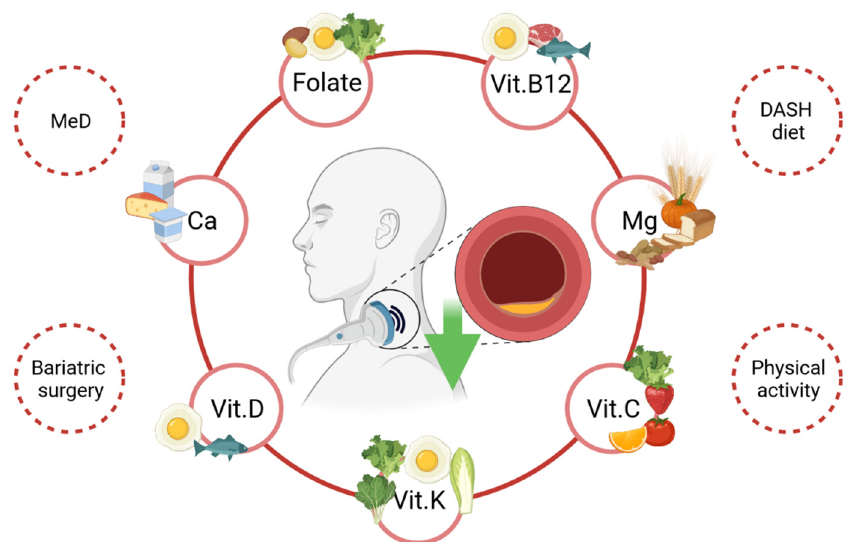
Figure 3. Behavioural and clinical factors that can reduce the cIMT values. MeD—Mediterranean diet; DASH—Dietary Approach to Stop Hypertension; vit.—vitamin; Mg—magnesium. Dietary sources of: calcium (dairy, milk); vit. D (oily fish, eggs); vit. K (green leafy vegetables, eggs), vitamin C (tomatoes, strawberry, green leafy vegetables, citruses); Mg (nuts, wholegrain cereals, pumpkin seeds); vit. B12 (meat, fish, eggs); folate (almonds, green leafy vegetables, eggs).